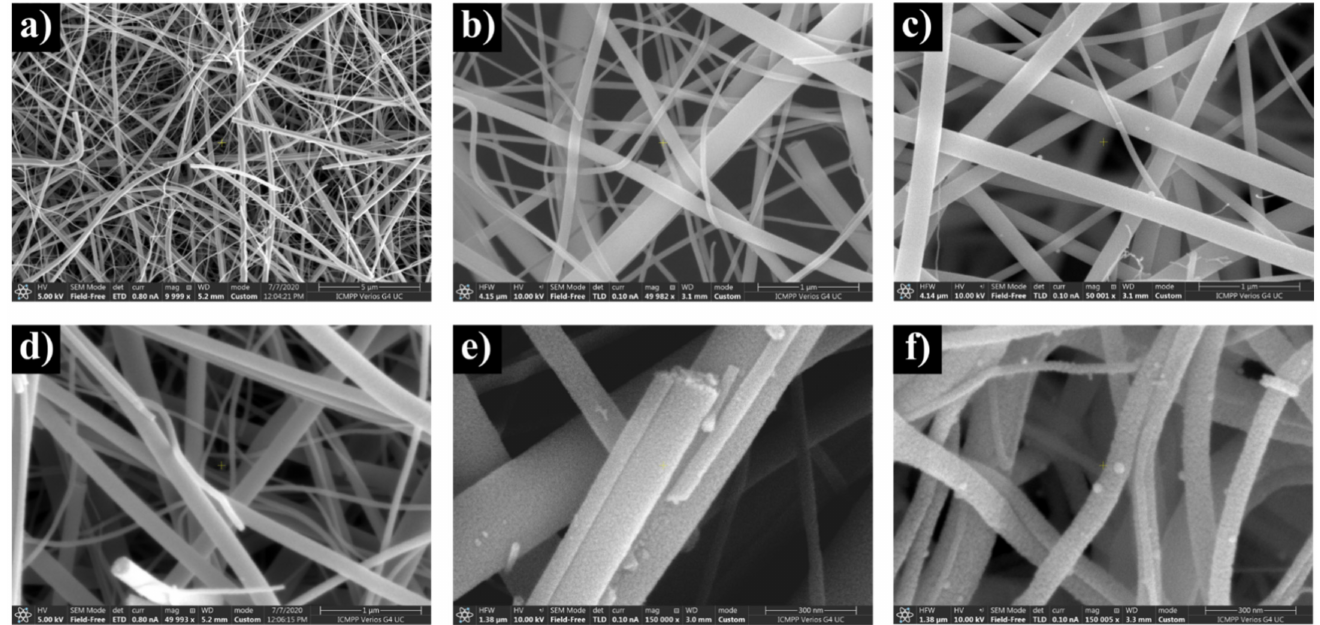
Figure 2. Small and larger magnification SEM images of Ag–TiO 2 nanostructured nanofibers: pure TiO 2 × 10,000 ( a ), 0.1% Ag–TiO 2 × 50,000 ( b ), 5.0% Ag–TiO 2 × 50,000 ( c ), TiO 2 × 50,000 ( d ), 0.1% Ag–TiO 2 × 150,000 ( e ), and 5.0% Ag–TiO 2 × 150,000 ( f ).